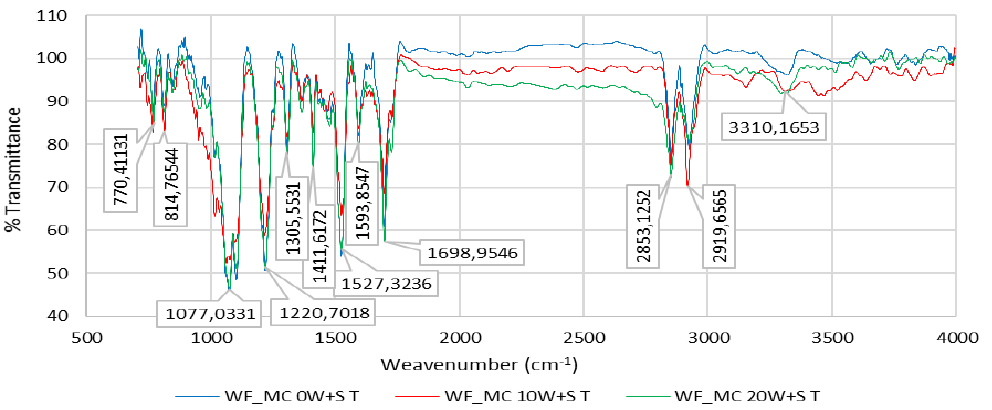
Figure 10. FTIR spectrum of the PU coating of sample WF_MC (40%/CO 60%) for 0 W + S, after 10 W + S and after 20 W + S.